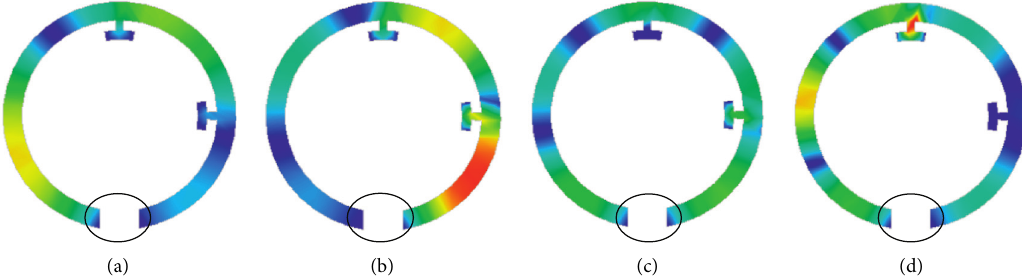
Figure 5: Current difference distribution between (a) J 8.8GHz.